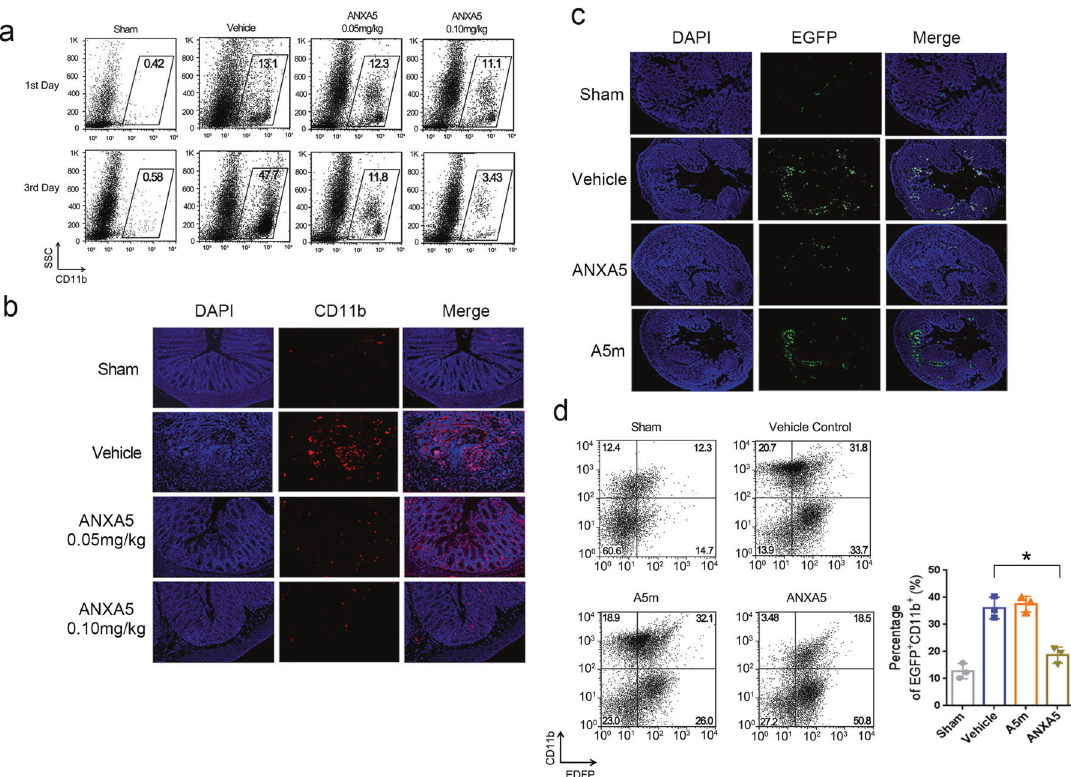
Fig. 5 ANXA5 inhibits the in fl ammatory cell in fi ltration. a Mice with TNBS induction were treated with ANXA5 at two different doses. Leukocytes in colonic mucosa were collected on day 1 and day 3, respectively, and stained with CD11b-APC for FACS analysis. b On day 3 after TNBS induction, colonic sections were stained with CD11b-APC (red) and DPAI (blue). c TNBS-colitic mice were pretreated with ANXA5 or A5m, and then received EGFP + in fl ammatory cells derived from EGFP mice. The in fi ltration of EGFP + cells was inhibited by ANXA5, not by A5m treatment. d The percentages of EGFP + CD11b + in the colon were analyzed by FACS. Data are representative of three independent experiments shown as mean ± SD ( n = 3 mice per group). * P < 0.05 versus the vehicle control group according to Student ’ s t